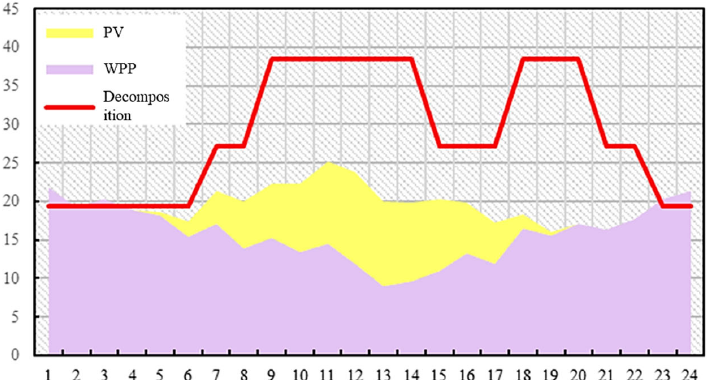
Figure 8. Contract power of VPP under insufficient output of renewable energy (MWh).